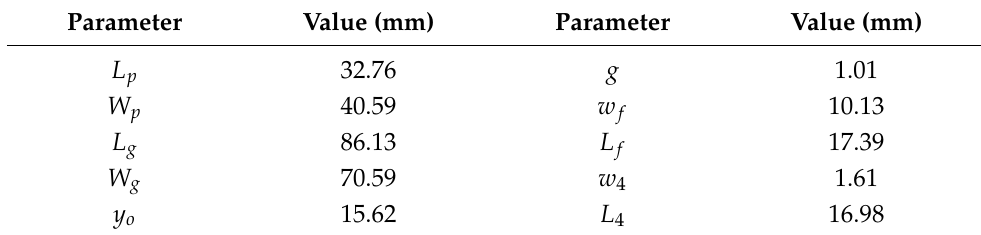
Table 2. The design parameters of the frequency-corrected